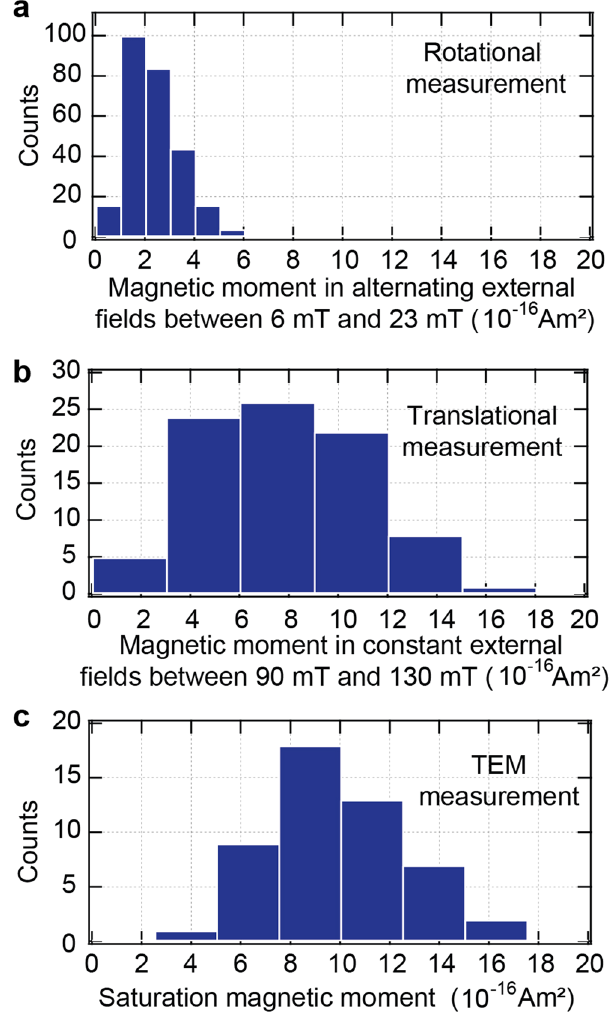
Figure 5. Distributions of the magnetic moments of single M. gryphiswaldense cells. ( a ) Magnetic moments determined by measuring the rotation of N = 265 cells in alternating magnetic fields. The field strengths ranged from B = 6 mT to 23 mT. ( b ) Magnetic moments determined by measuring the translation of N = 86 cells in static magnetic fields. The field strengths ranged from B = 90 mT to 130 mT. ( c ) Saturation magnetic moments of N = 50 cells determined by measuring the total magnetosome volume of each cell with